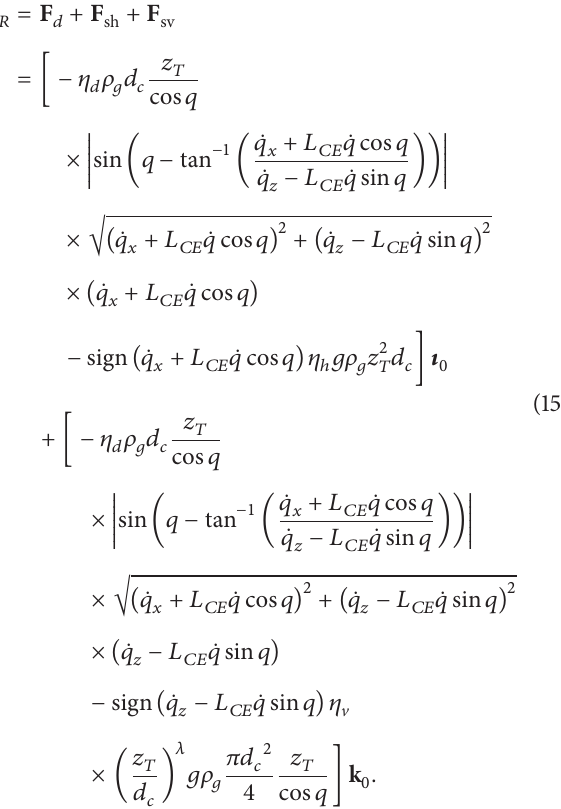
3.1. Results. Figure 4 represents the simulation results of the penetrating depth of the end link, 𝑧 𝑇 , and its vertical velocity 𝑞(0) = 0 ∘ . The simulations V 𝑇 𝑧 , for the vertical impact